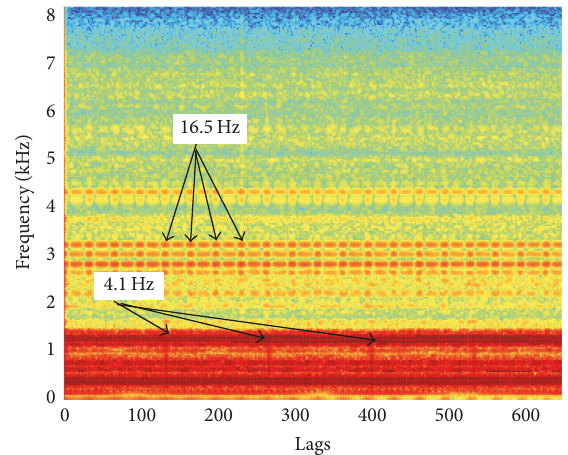
Figure 3: Codifference map of the investigated signal. Figure 4: Covariation map of the investigated